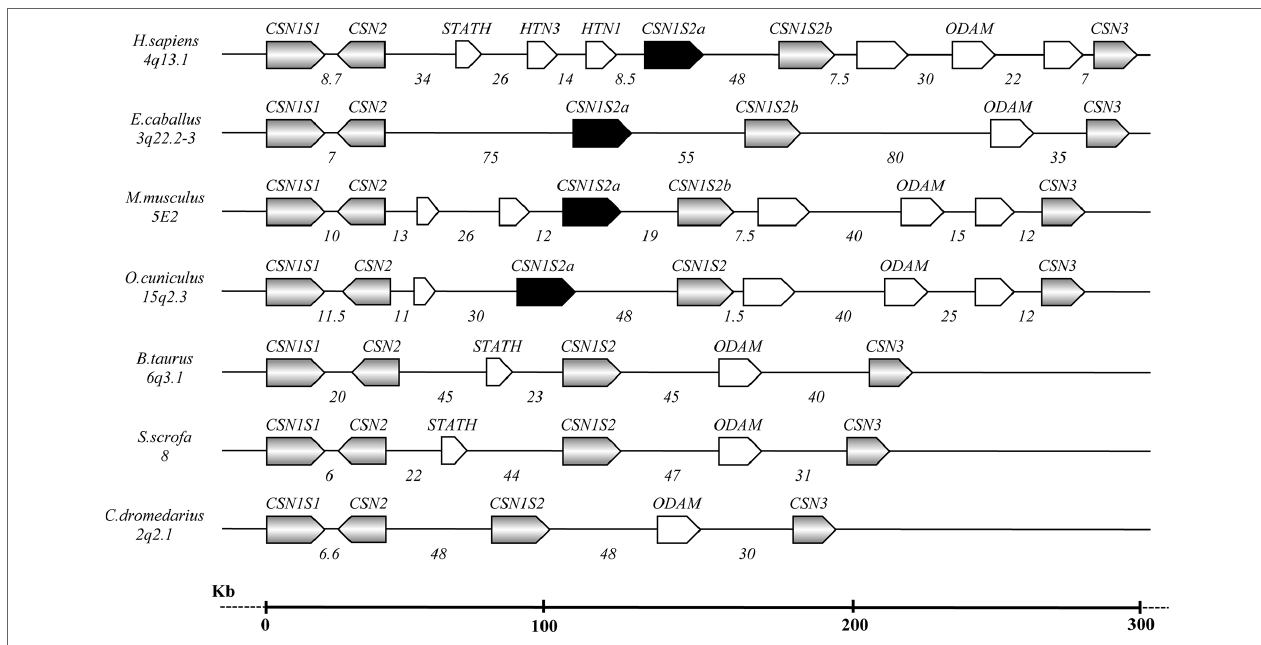
FIGURE 1 | Schematic representation of the casein gene cluster in different species, chromosome location, gene orientation, and related intergenic distances based on comparative genomic analysis (Modified from Martin et al., 2013 and Ryskaliyeva et al.,